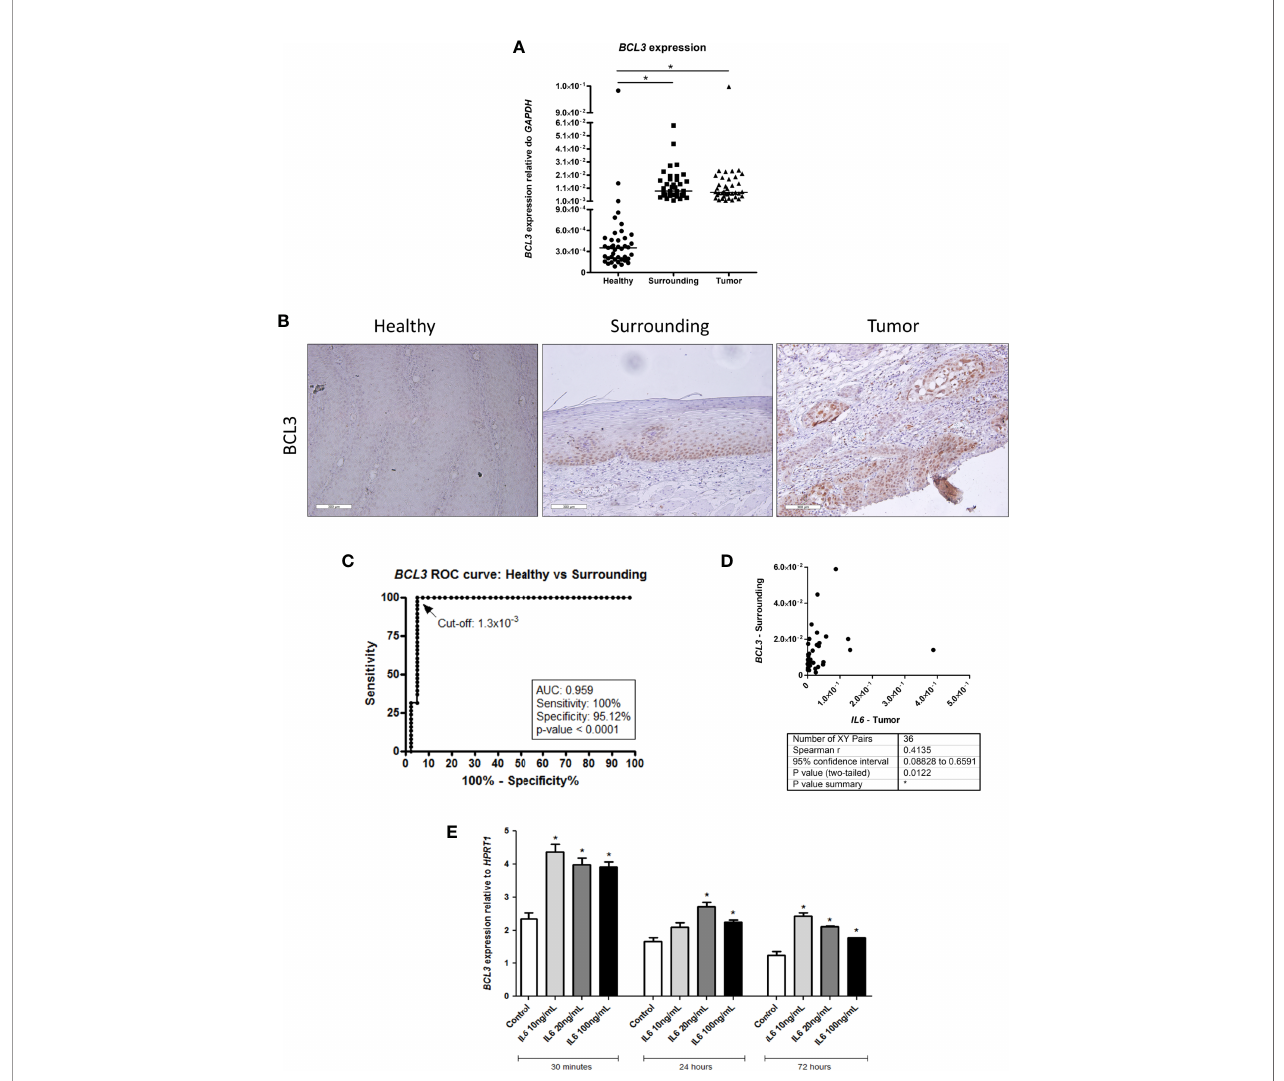
FIGURE 2 | BCL3 expression in healthy esophagus and ESCC. (A) Dot-plot representing BCL3 mRNA expression normalized with GAPDH in esophageal mucosa from individuals without esophageal disorders (Healthy), histologically normal tumor-surrounding tissues from ESCC patients (Surrounding), and ESCC (Tumor). (B) Representative FFPE slides from immunohistochemistry performed with BCL3 antibody in esophageal mucosa from individuals without esophageal disorders (Healthy), histologically normal tumor-surrounding tissues from ESCC patients (Surrounding), and ESCC (Tumor). Sections were counterstained with Harris ’ hematoxylin. All images are shown in 20X magni fi cation and 300 µm scale bars are shown. (C) Receiver Operating Characteristic (ROC) curve showing the sensitivity and speci fi city of BCL3 mRNA expression normalized with GAPDH to distinguish Healthy from Surrounding. BCL3 expression cut-off of 1.3x10-3 showed the highest accuracy (95.89%), sensitivity (100%) and speci fi city (95.12%) (p < 0.0001). (D) Correlation analysis between IL6 expression in tumor samples (X-axis) and BCL3 expression in the non-tumor surrounding tissue (Y-axis) from the same patient. Each dot represents an ESCC patient. (E) Bar graphs showing BCL3 mRNA expression normalized with HPRT1 in HET-1A esophageal cells after IL6 treatment in different doses for different periods of time. *p <